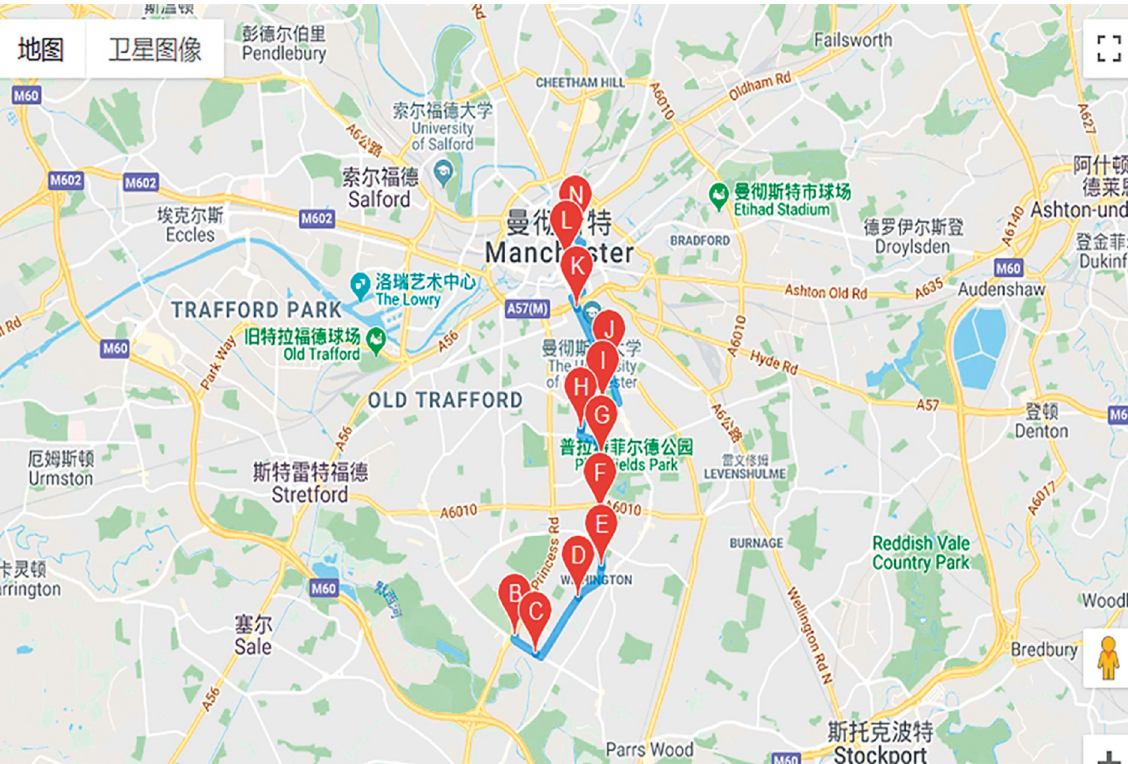
Figure 10: A bus